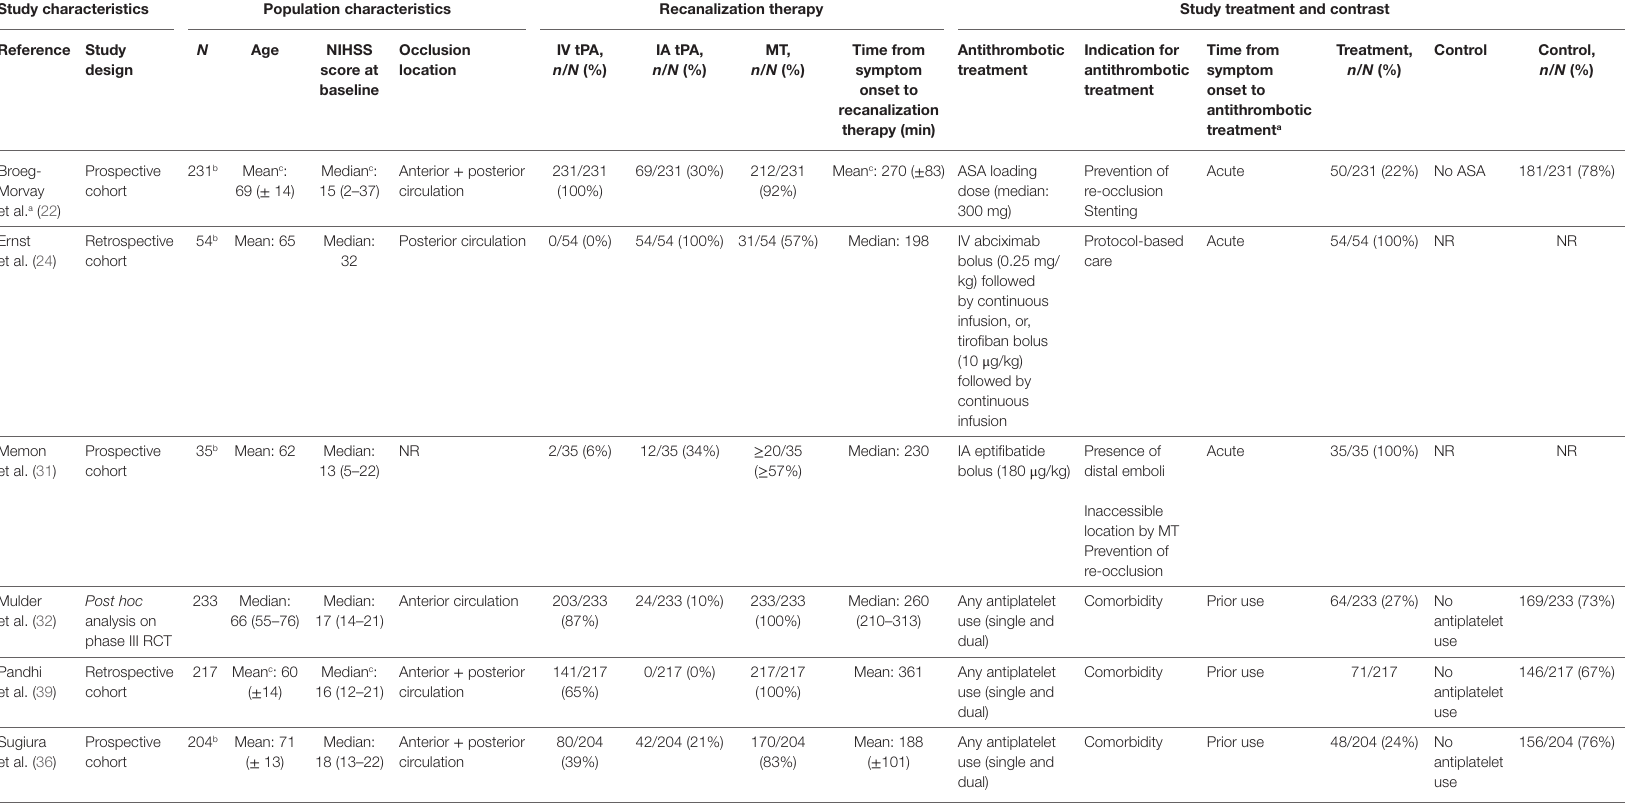
taBLe 1 | Characteristics of included studies investigating periprocedural antiplatelet use in patients with ischemic stroke who underwent acute